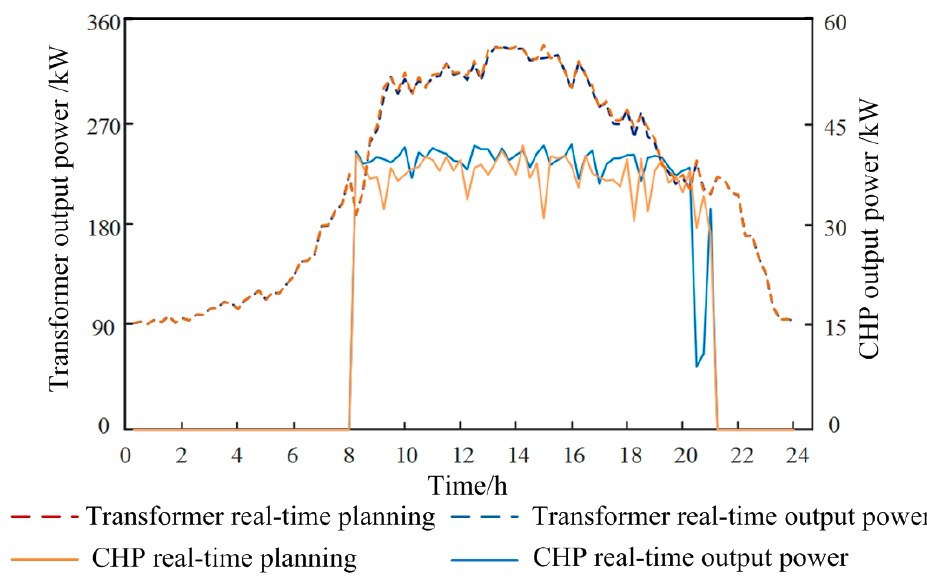
Figure 5. Comparison between real-time planning and actual output of electric load.